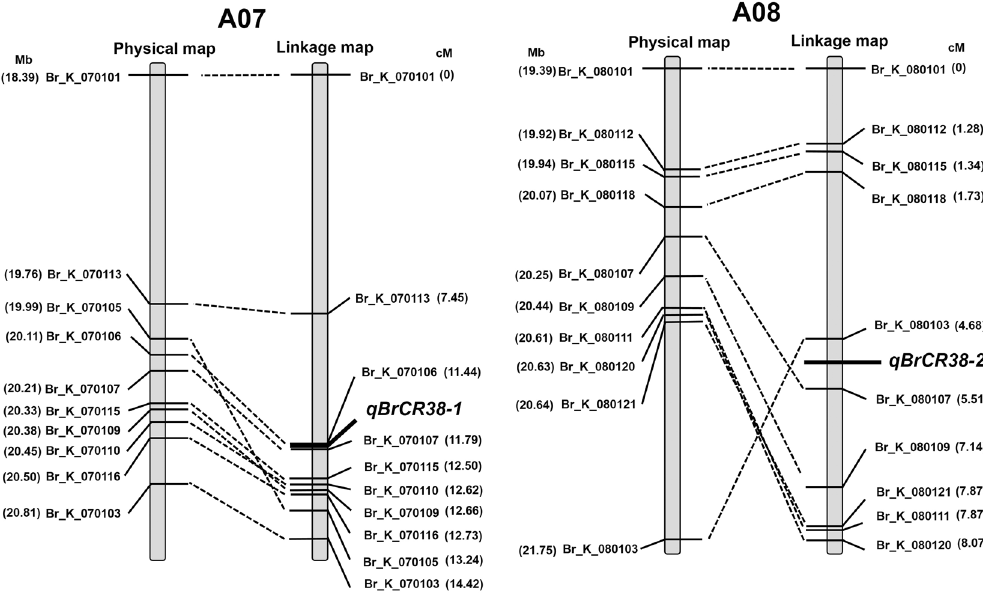
Figure 4. The physical map corresponds to the genetic map around region of qBrCR38-1 and qBrCR38-2 . Broken lines drawn regions defined by KASP markers on chromosome A07 and A08. Physical locations are on the left, and the genetic distance is shown on the